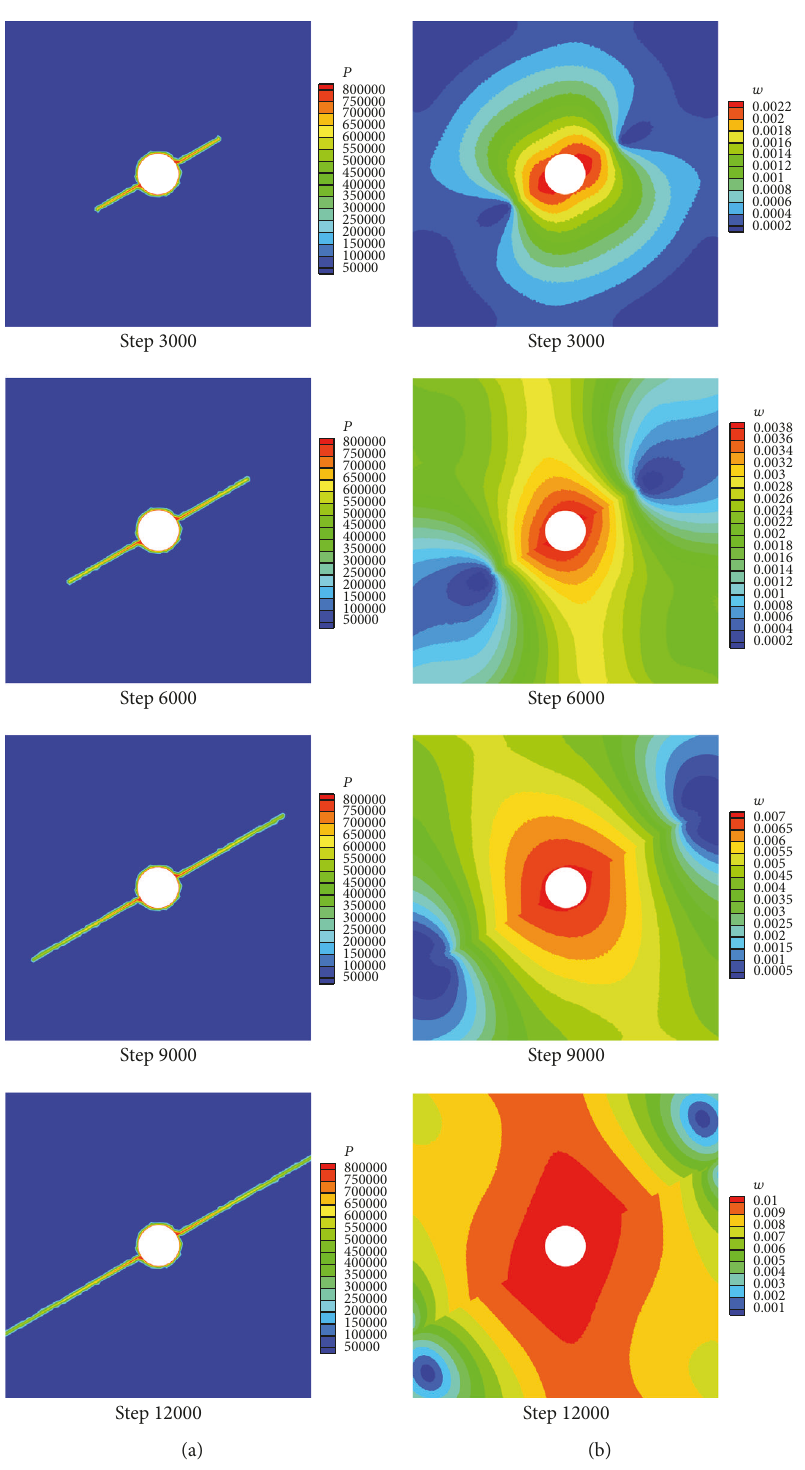
Figure 16: (a) Fracture geometry and hydraulic pressure distribution of model I; (b) displacement magnitude